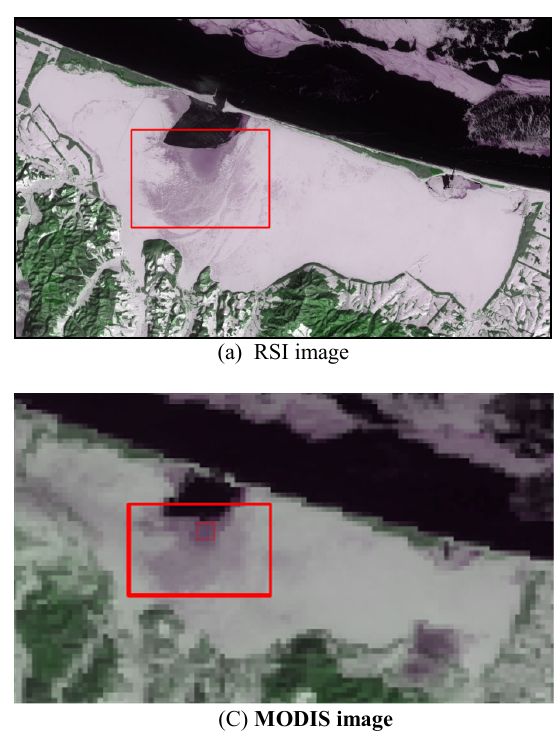
Figure 6. Comparison of RAI image with MODIS image (Saroma Lake, February 19, 2011)